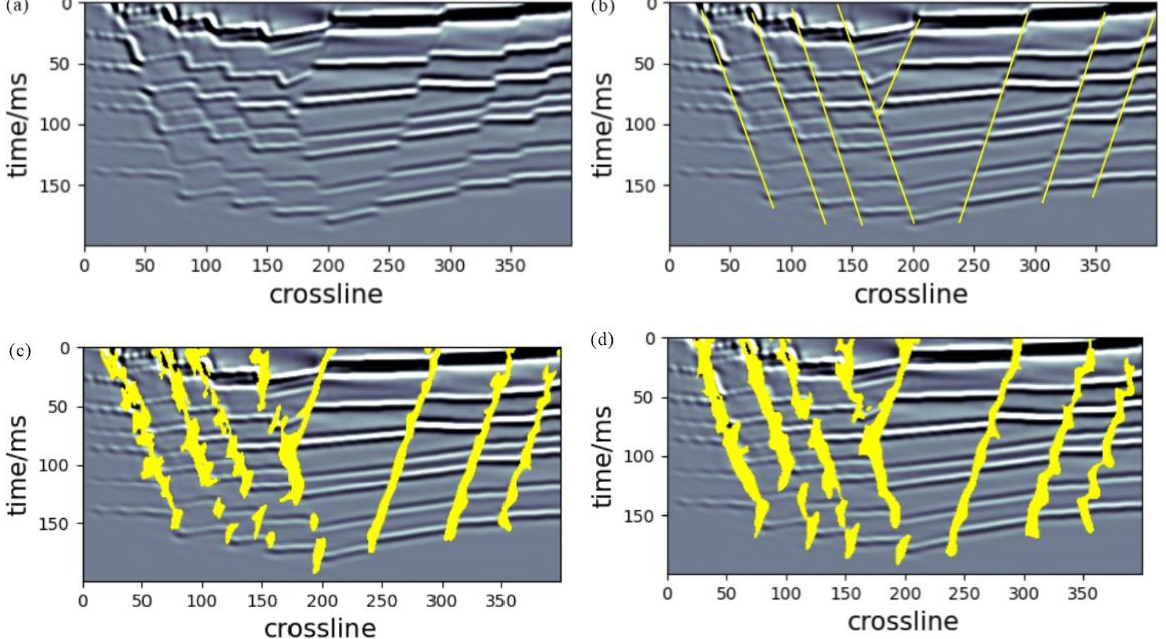
Figure 11. Prediction renderings of UNet model and SE-UNet model. ( a ) Seismic profile of Inline10; ( b ) fault labels corresponding to the Inline10seismic profile; ( c ) UNet recognition; ( d ) SE-UNet recognition.